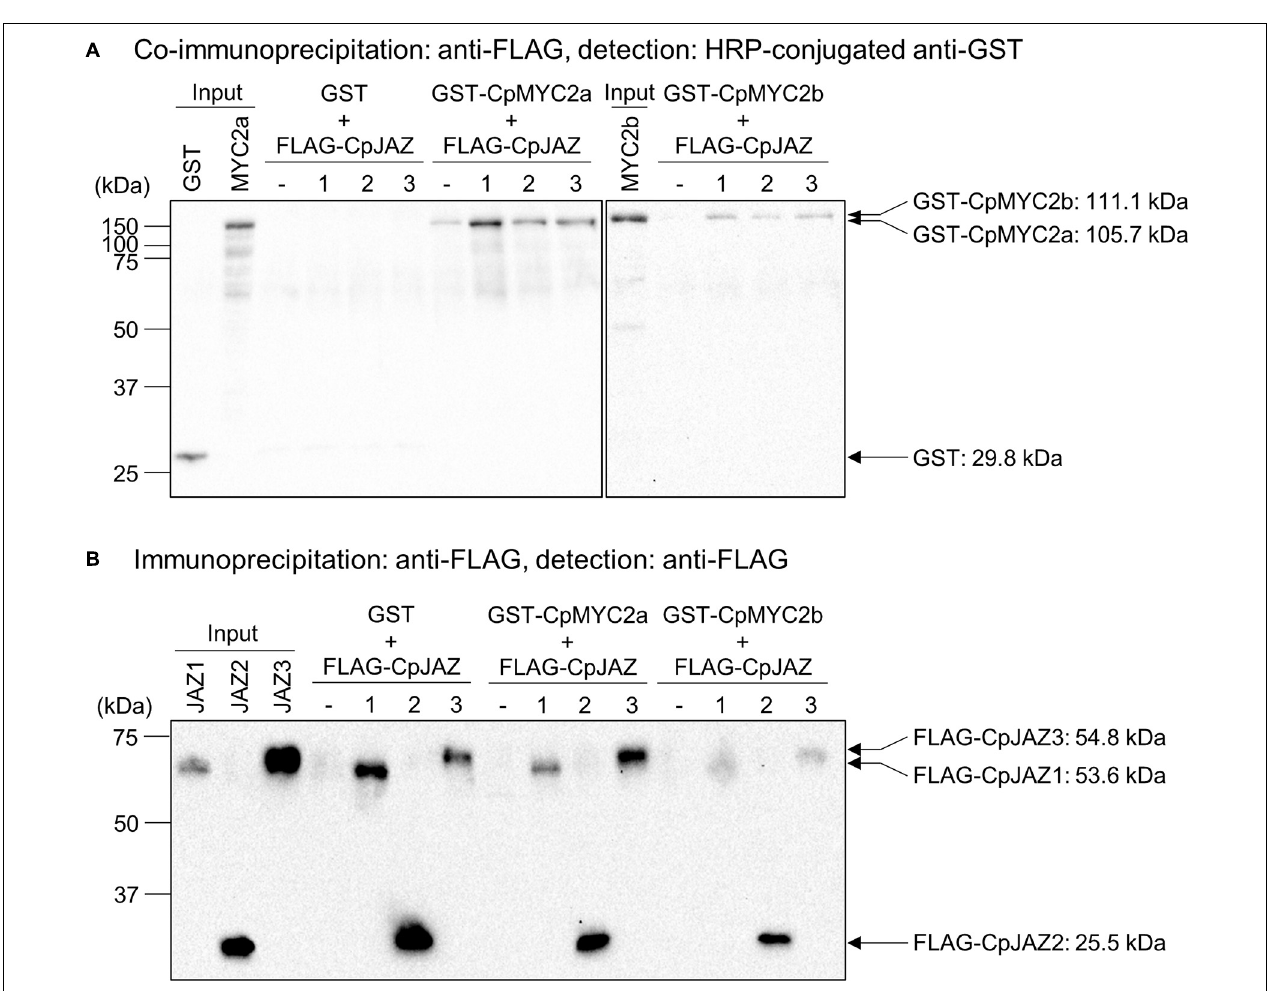
FIGURE 6 | Co-immunoprecipitation analysis investigating the interaction between CpJAZs and CpMYC2s. (A) Proteins co-immunoprecipitated by anti-FLAG antibodies were analyzed. GST and GST-fused proteins were detected by protein gel blot analysis using a horseradish peroxidase-conjugated anti-GST antibody. (B) Proteins immunoprecipitated by anti-FLAG antibody were analyzed. FLAG-tagged proteins were detected by protein gel blot analysis using an anti-FLAG antibody.